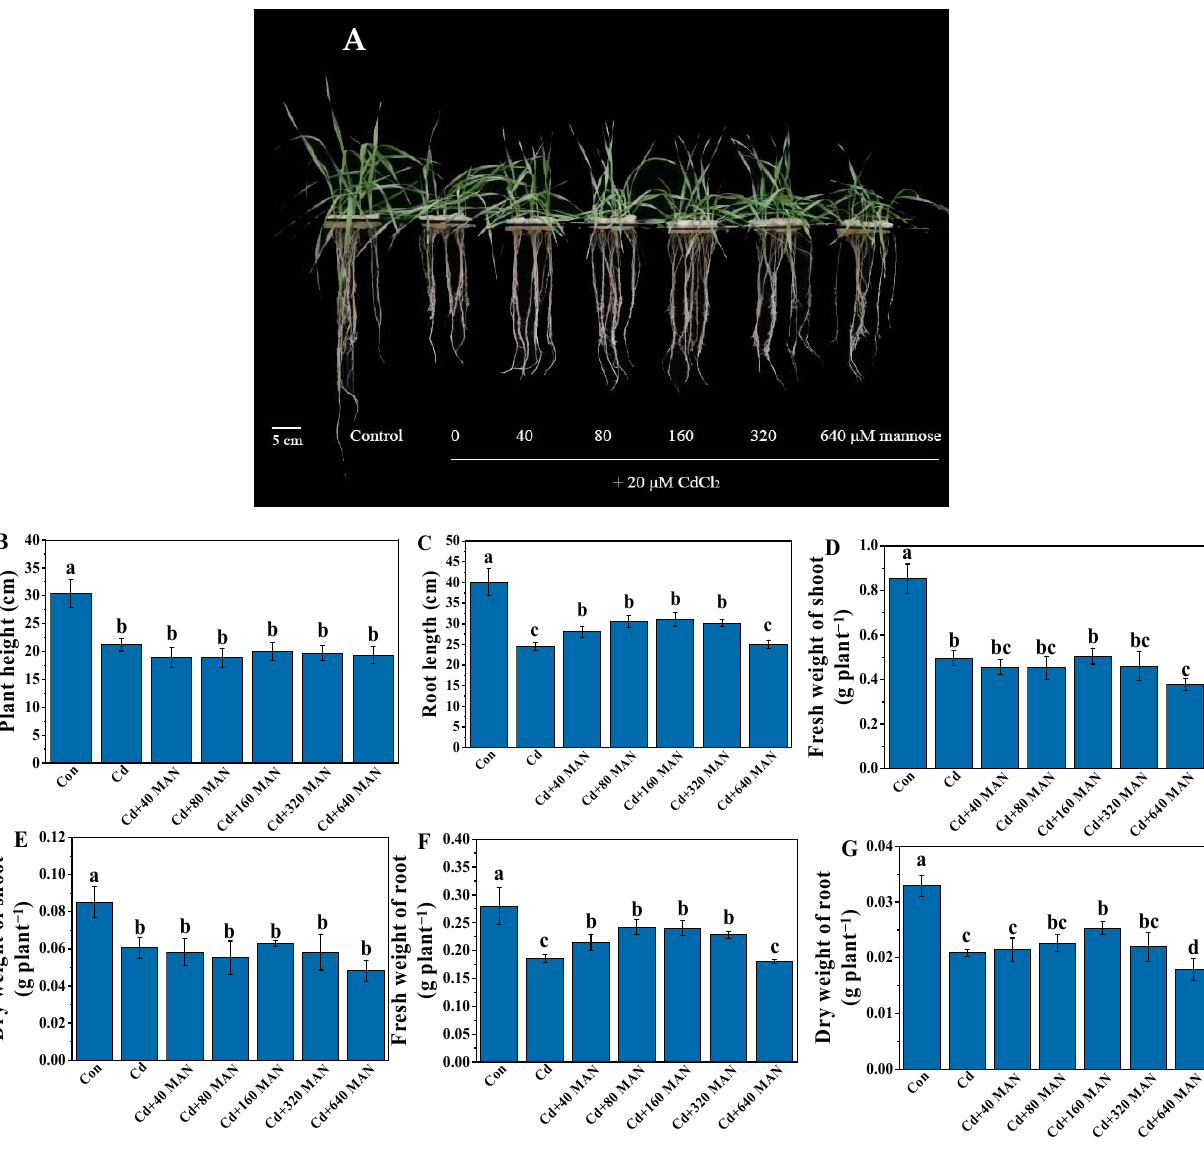
Figure 1. Effects of different concentration of MAN on wheat ( A ); plant height ( B ); root depth ( C ); FW of shoot ( D ); DW of shoot ( E ); FW of root ( F ) and DW of root ( G ) under Cd stress. One-week-old wheat seedlings under 20 µ M CdCl 2 were sprayed with 0, 40, 80, 160, 320, or 640 µ M MAN for two weeks. Data are the means ± SD and different letters above columns indicate a significant difference at p ≤ 0.05 among treatments.